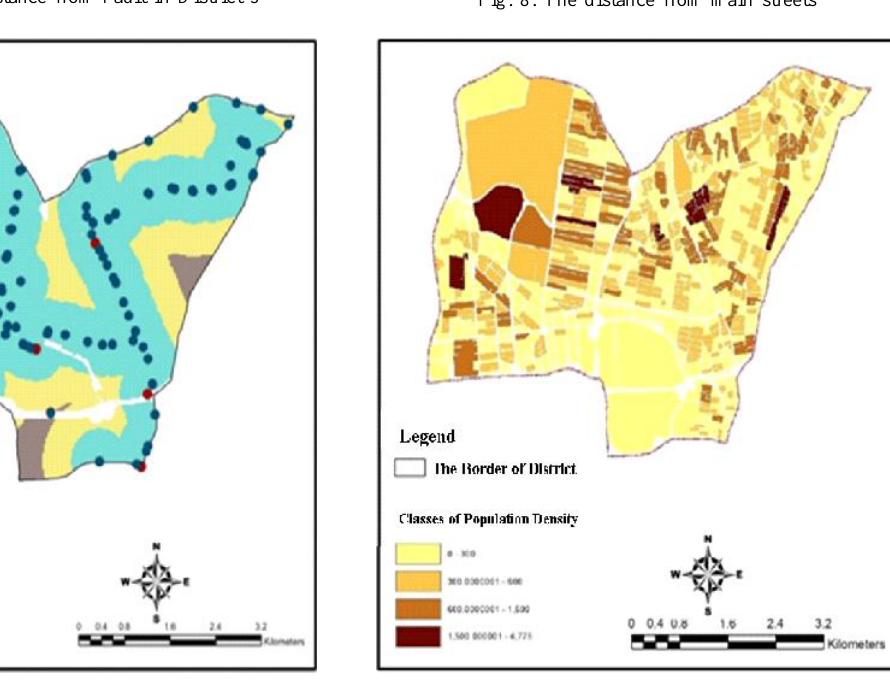
Fig. 7: The distance from transports stations